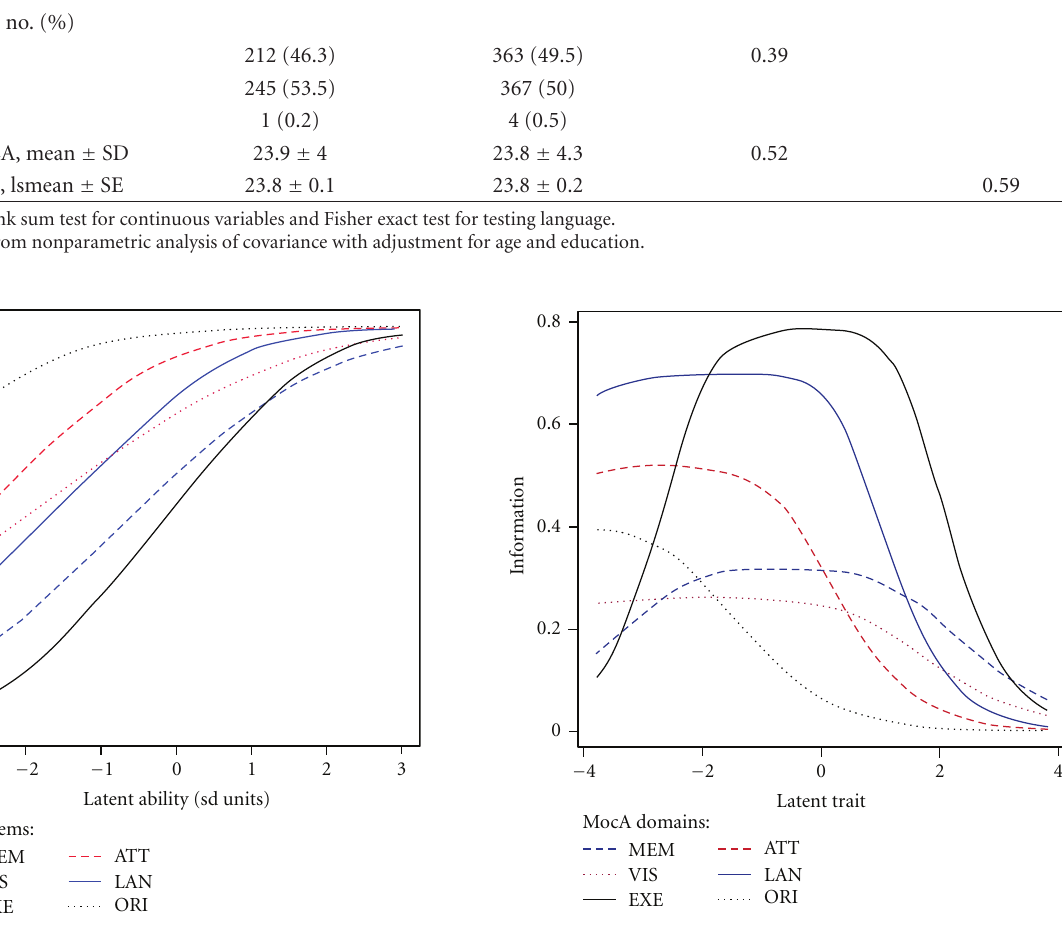
Figure 7: Test information curves (TICs) for the MoCA-ChLA domain scores in the total sample MEM: short-term memory; VIS: visuospatial construction; EXE: executive function; ATT: attention and concentration; LAN: language; ORI: temporal and spatial